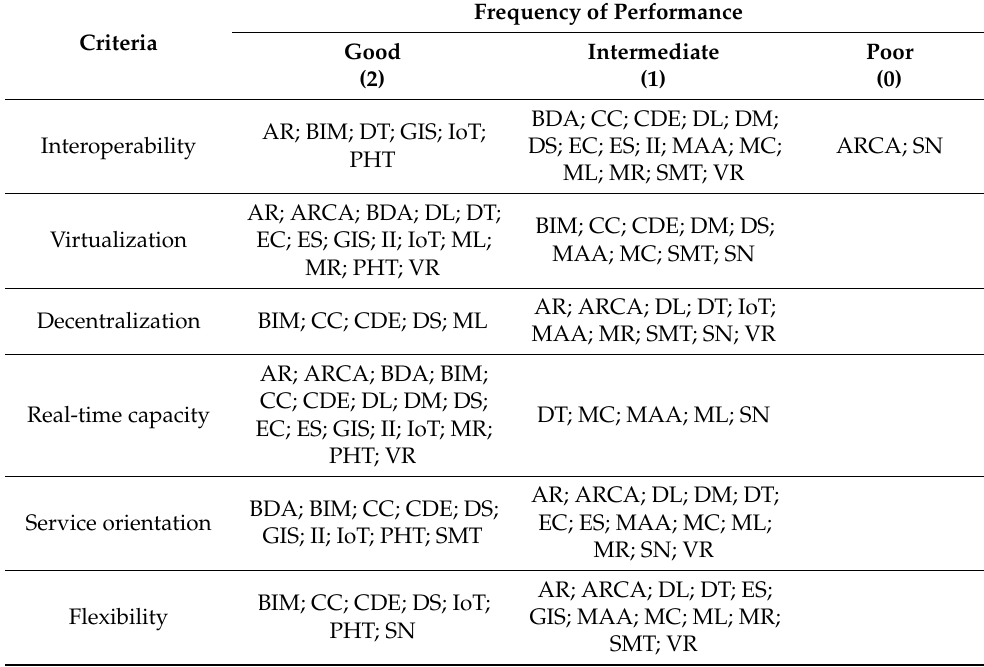
Table 15. Frequencies obtained according to the criteria for